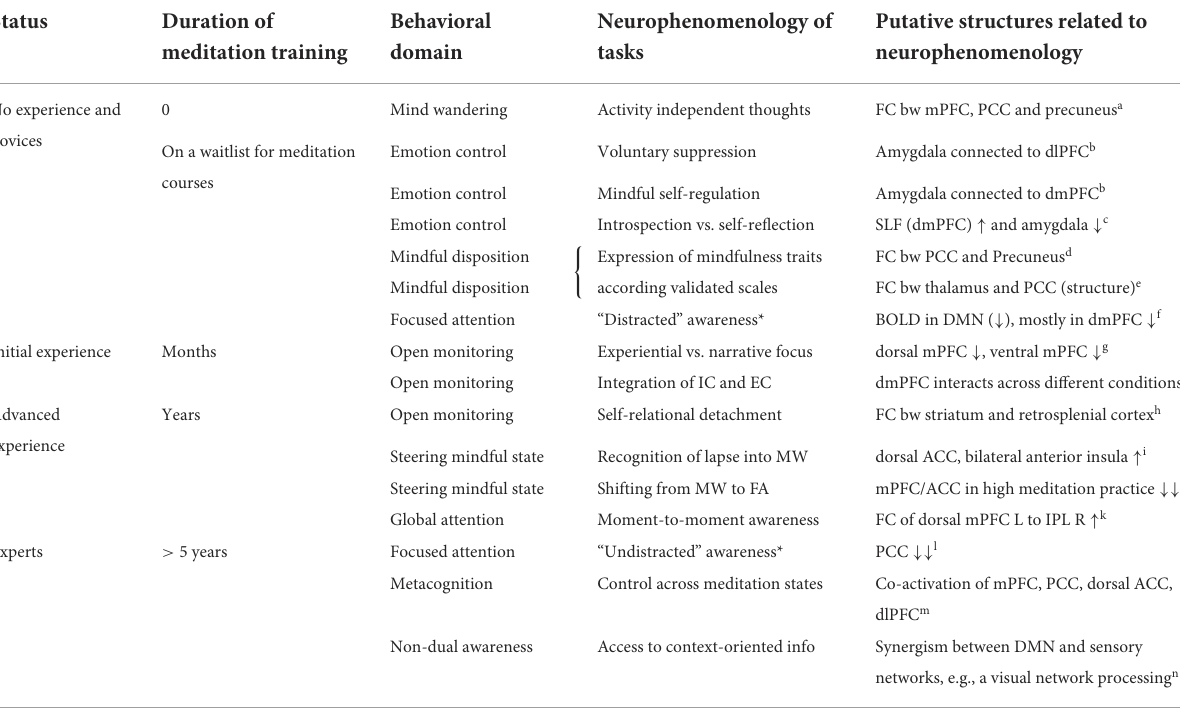
TABLE 3 The self-specifying process in mindfulness from subjects naïve in mindfulness to expert status proficient in the metacognitive